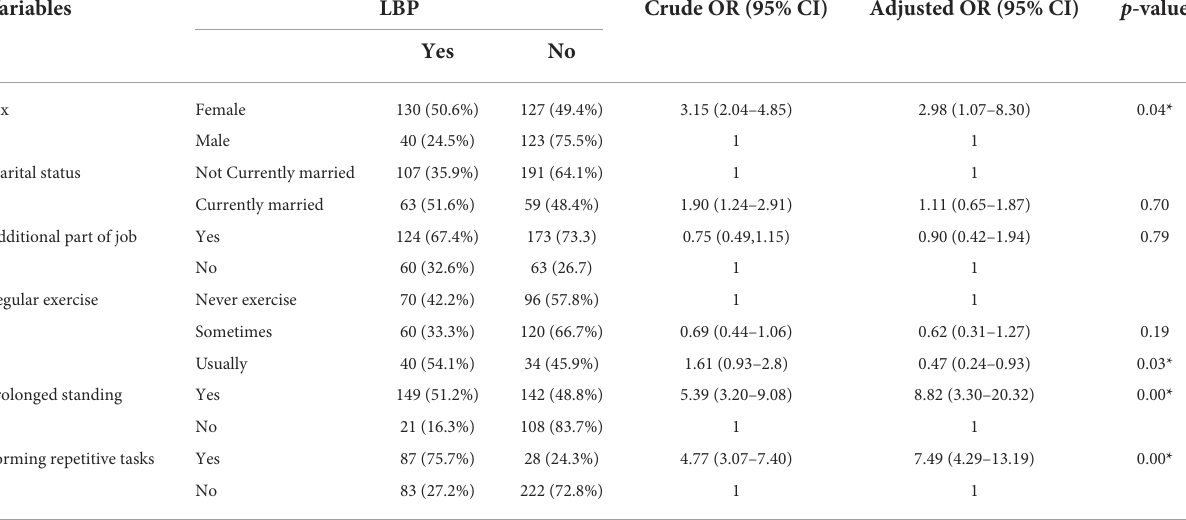
TABLE 4 Bi-variable and multivariable logistic regression analysis on factors associated with low back pain among restaurant wait staff in Gondar town, Ethiopia, 2019 ( n = 420). Variables LBP Crude OR (95%